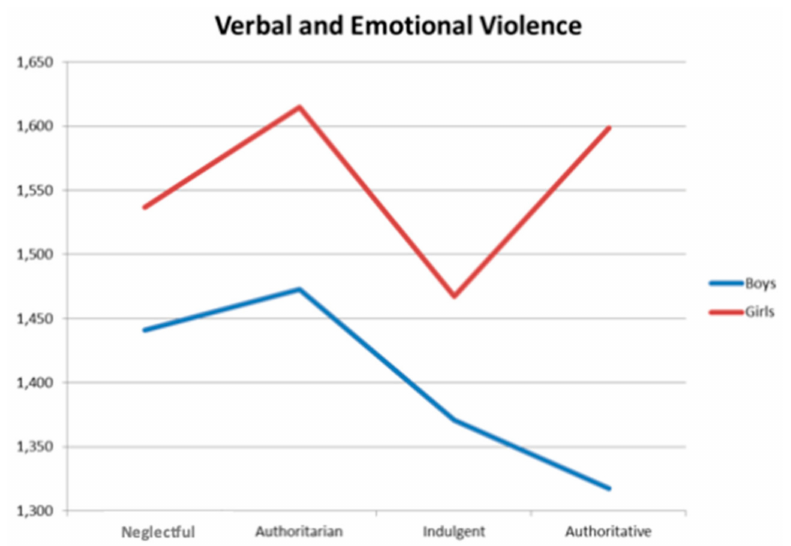
Figure 3. Iteration e ff ect on verbal and emotional violence of the father´s